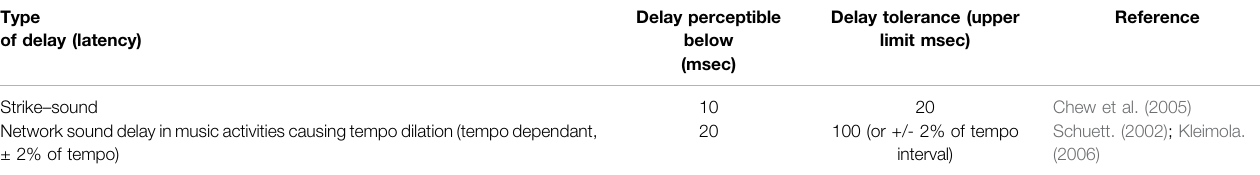
TABLE 1 | Summary of latency/delay perception and tolerance in common music systems.